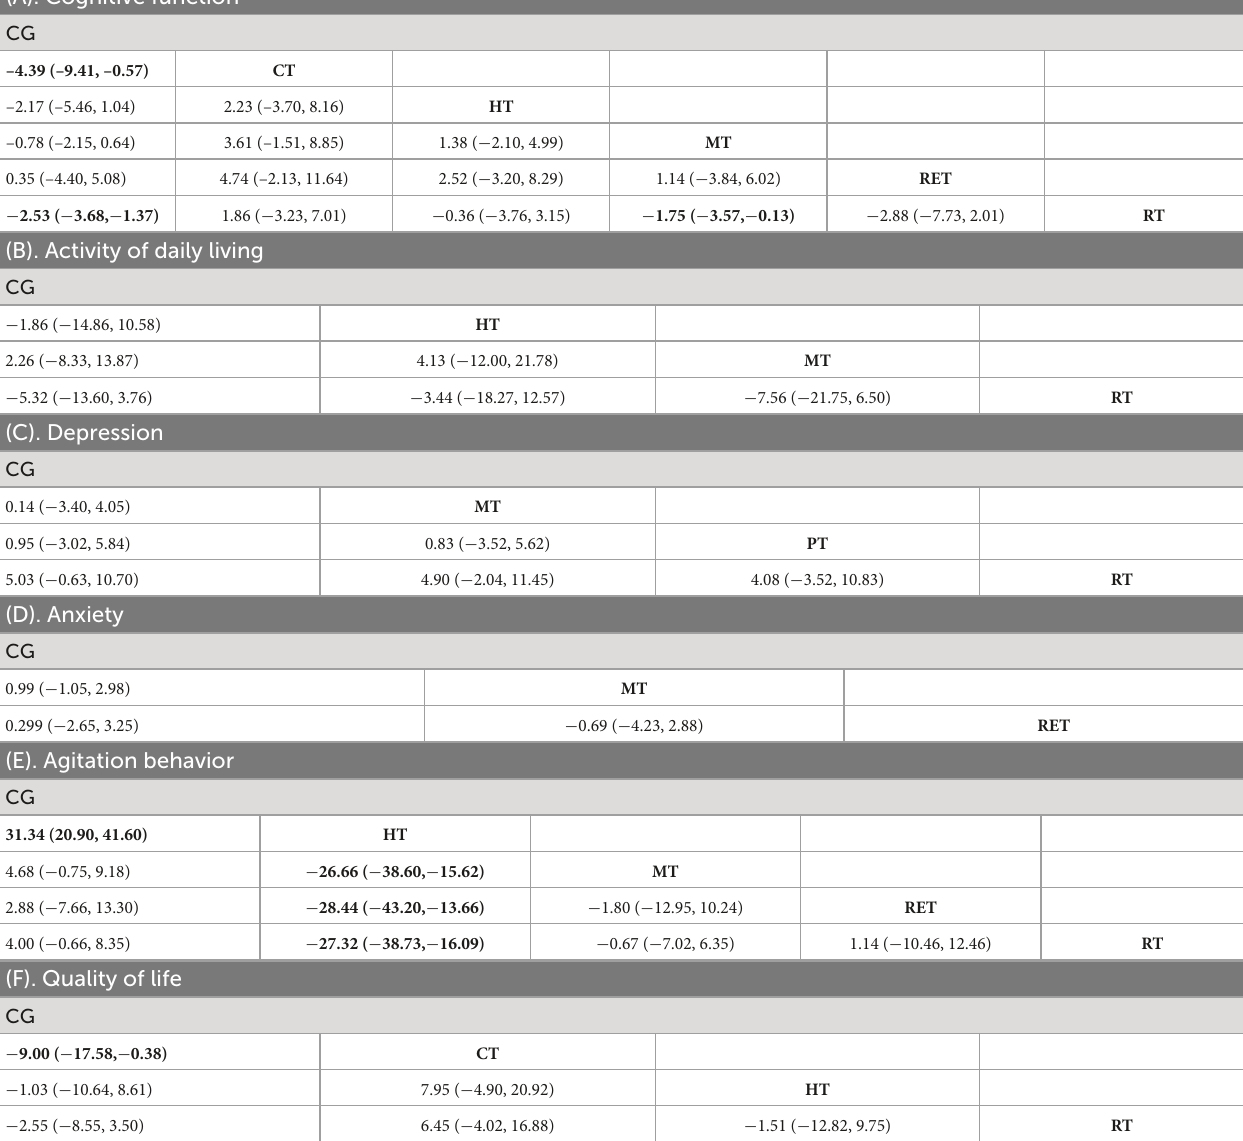
TABLE 1 League tables for comparing different